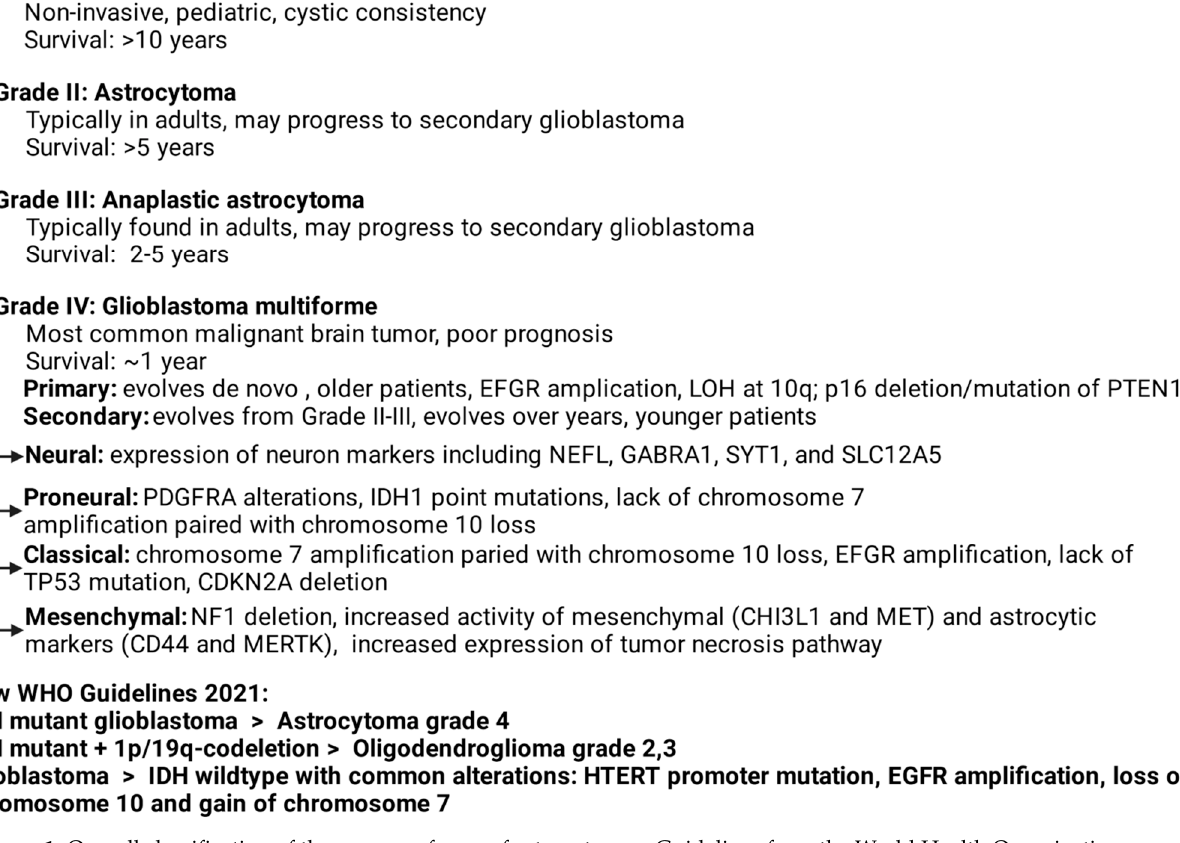
Figure 1. Overall classification of the common forms of astrocytomas. Guidelines from the World Health Organization were updated in 2021. The overall heterogeneity of CNS tumors makes nomenclature and histologic distinction a critical but challenging task in the wake of novel technologies [17,18]. Treatment options at presentation have remained relatively stable for many years with few novel treatments or targeted therapies showing efficacy. The current standard of care is surgery followed by combination radiotherapy and temozolomide chemotherapy in the case of glioblastoma with methylated O 6 -methylguanine-DNA-methyltransferase (MGMT). In cases with unmethylated MGMT, the addition of alternating electric fields therapy has shown promise in clinical trials and is included in front-line treatment in the National Comprehensive Cancer Network (NCCN) guidelines. Due to its tendency to be hypervascularized, the anti-angiogenic bevacizumab is commonly used as a second-line therapeutic in combination with agents like the alkylating mustard carmustine or lomustine [19–21]. Resistance to these therapies is based on two major factors: maintenance of stemness and overall dissemination. GBMs rarely metastasize to distant sites, but, through an EMT-like process (glial-to-mesenchymal transition) specific to the brain, they can disseminate widely throughout the CNS, making GBM a disease of the entire brain [22–24].